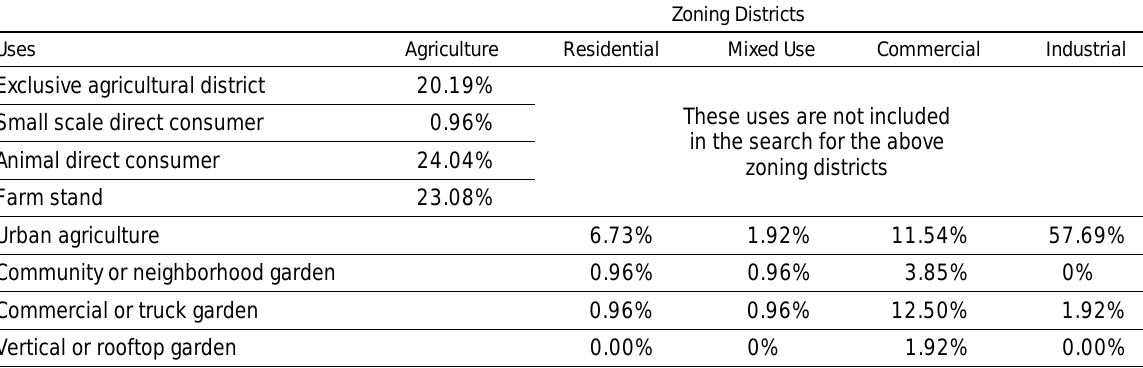
Table 5. Presence of Uses in the Production